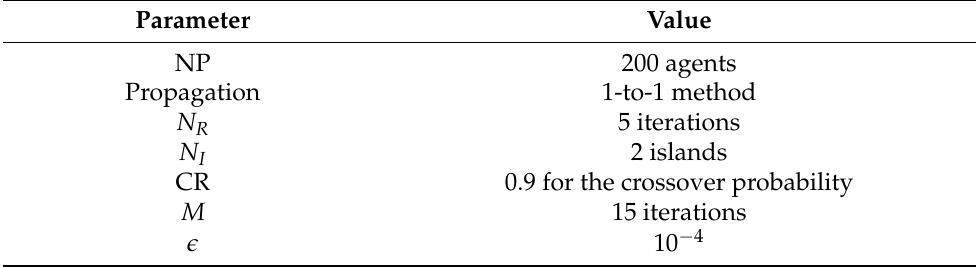
Table 1. Experimental settings.